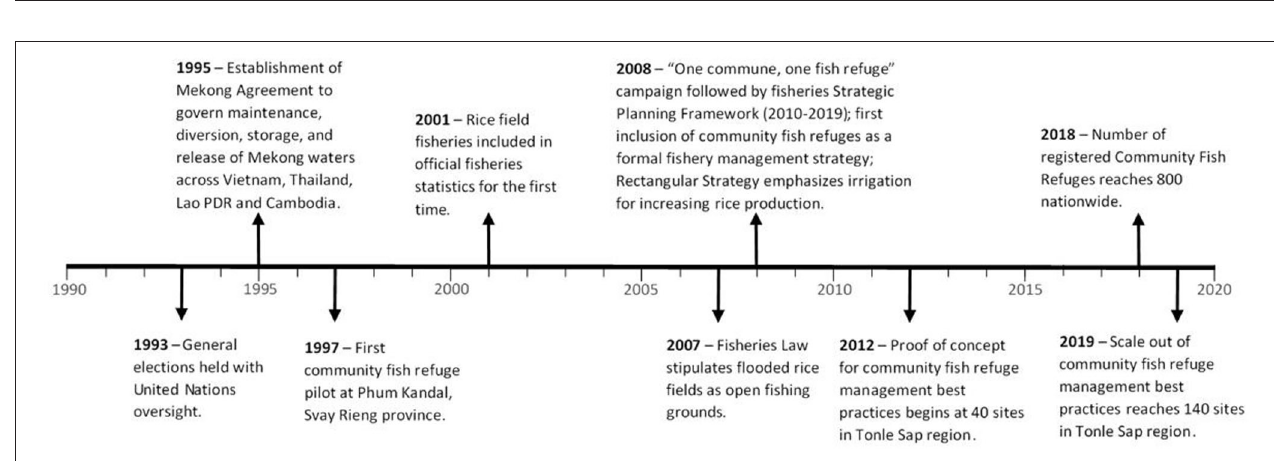
FIGURE 3 | Timeline of events that influenced rice-fish production practices in